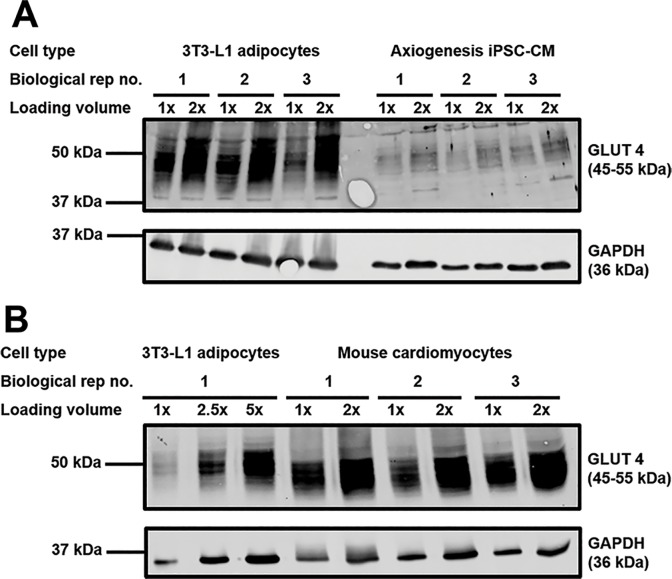
GLUT4 protein expression in different cardiomyocyte models.Protein lysates generated from 3T3-L1 adipocytes, primary adult mouse cardiomyocytes, and iPSC-CM were subjected to SDS-PAGE and immunoblotting. Lysates were incubated with antibodies probing for GLUT4 (1:2000, 1% milk, PBS-T) and GAPDH (1:80,000, 1% milk, PBS-T). Two different amounts of each sample of cardiomyocyte lysate from three biologically independent sources were loaded, in addition to at least three samples of 3T3-L1 adipocyte lysate. For each cell type, 1x refers to lysate generated from approximately 15,000 (3T3-L1 adipocytes) or 17,500 (iPSC-CM) cells, or approximately 20 μg of protein (mouse cardiomyocytes). Panel A compares 3T3-L1 adipocytes and iPSC-CMs; Panel B compares 3T3-L1 adipocytes and primary mouse cardiomyocytes.